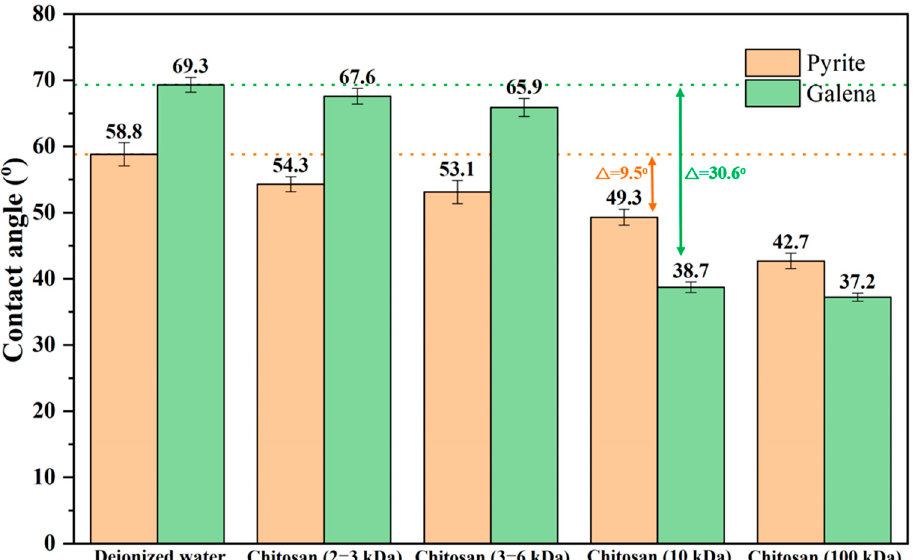
Figure 6. The e ff ect of the addition of chitosan with di ff erent molecular weights (400 g / t) on the contact Figure 6. The effect of the addition of chitosan with different molecular weights (400 g/t) on the contact angles of ( a ) pyrite and ( b ) angles of ( a ) pyrite and ( b ) galena.